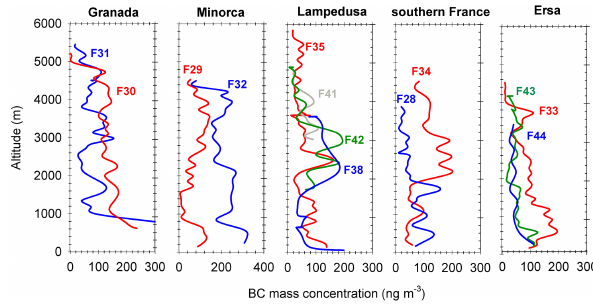
Figure 17. Vertical profiles of rBC concentrations estimated from the SP2 instrument for five different zones (Granada, Minorca, Lampedusa, southern France and